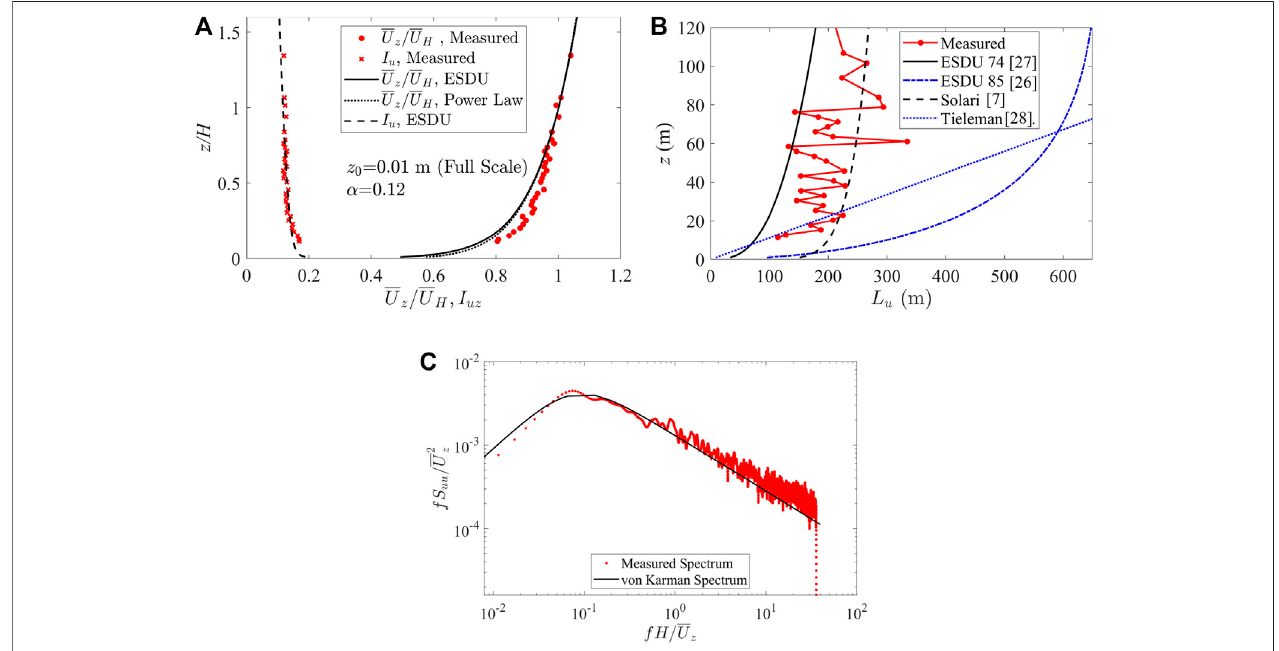
FIGURE 1 | (A) Wind speed pro fi le, turbulence intensity pro fi le (B) integral length scale pro fi le (in full scale dimensions) and (C) longitudinal wind velocity spectra at full-scale height, z (cid:1) 76.2 H .